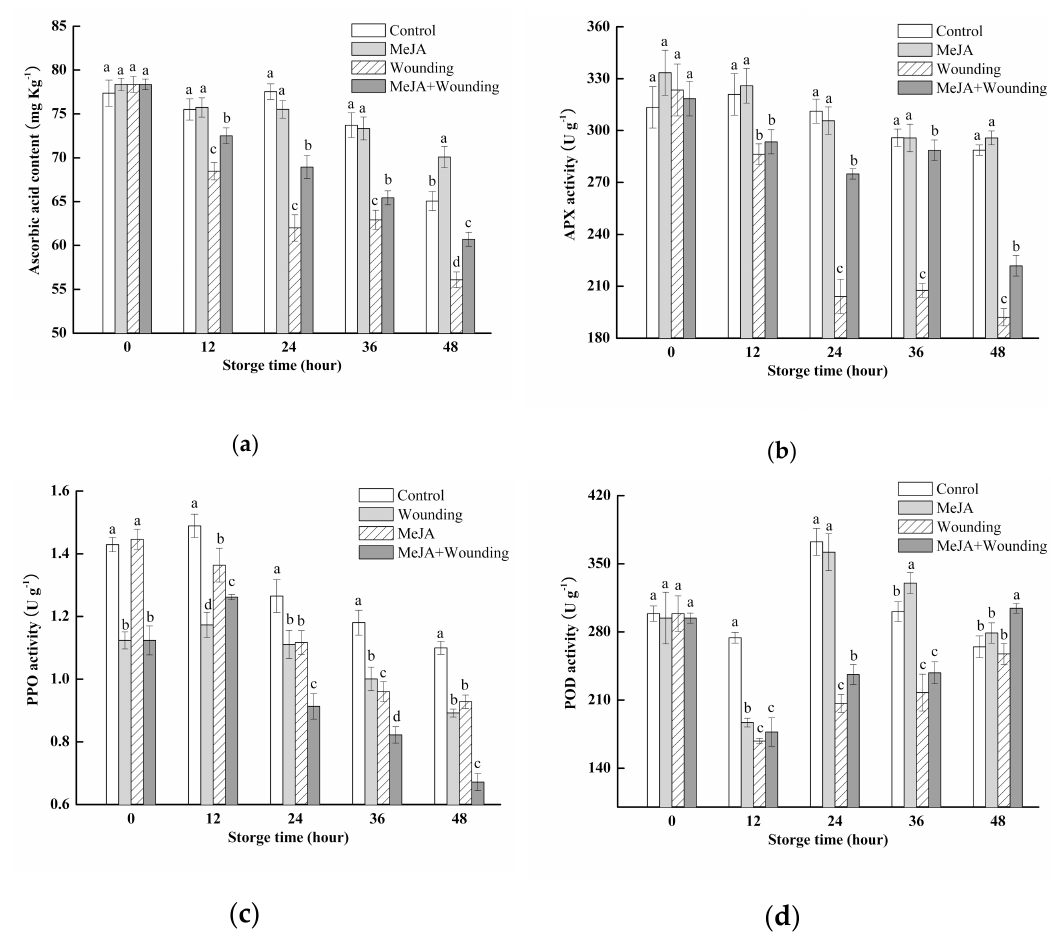
Figure 6. Effect of MeJA treatment and wounding stress on vitamin C content ( a ), APX ( b ), PPO ( c ) and POD ( d ) activities of broccoli during 48 h of storage at 20 °C. Columns with vertical bars represent the mean ±SD ( n = 3).